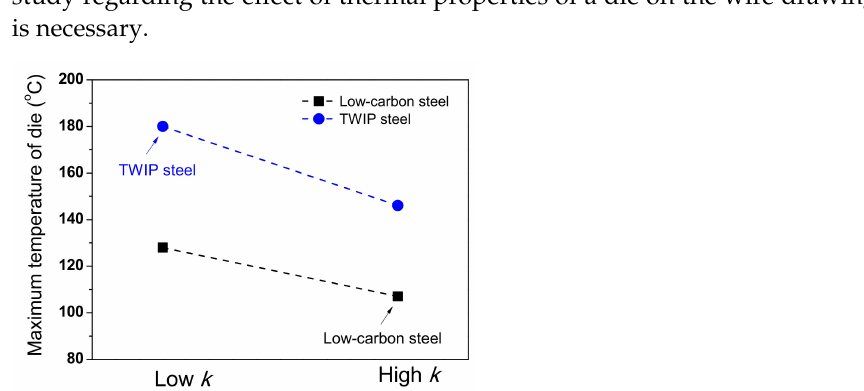
Figure 15. Comparison of maximum temperature of die for low-carbon and TWIP steels with different thermal conductivities based on Figures 11 and 13.